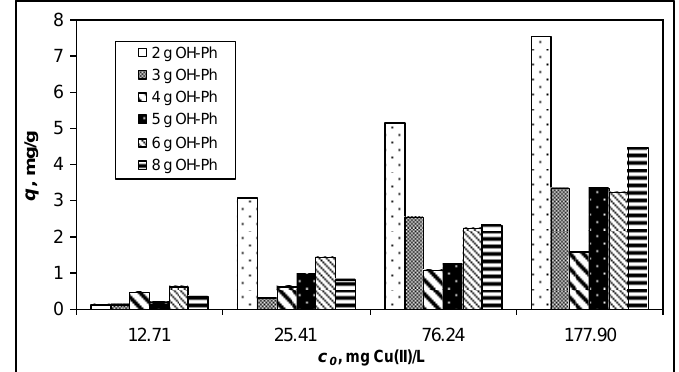
Figure 2. Adsorption capacities of functionalized PET waste with different amounts of phenol (Ph), for Cu(II) ions from aqueous media (pH = 6.5, contact time = 24 h, adsorbent dose = 8 g L − 1 ).